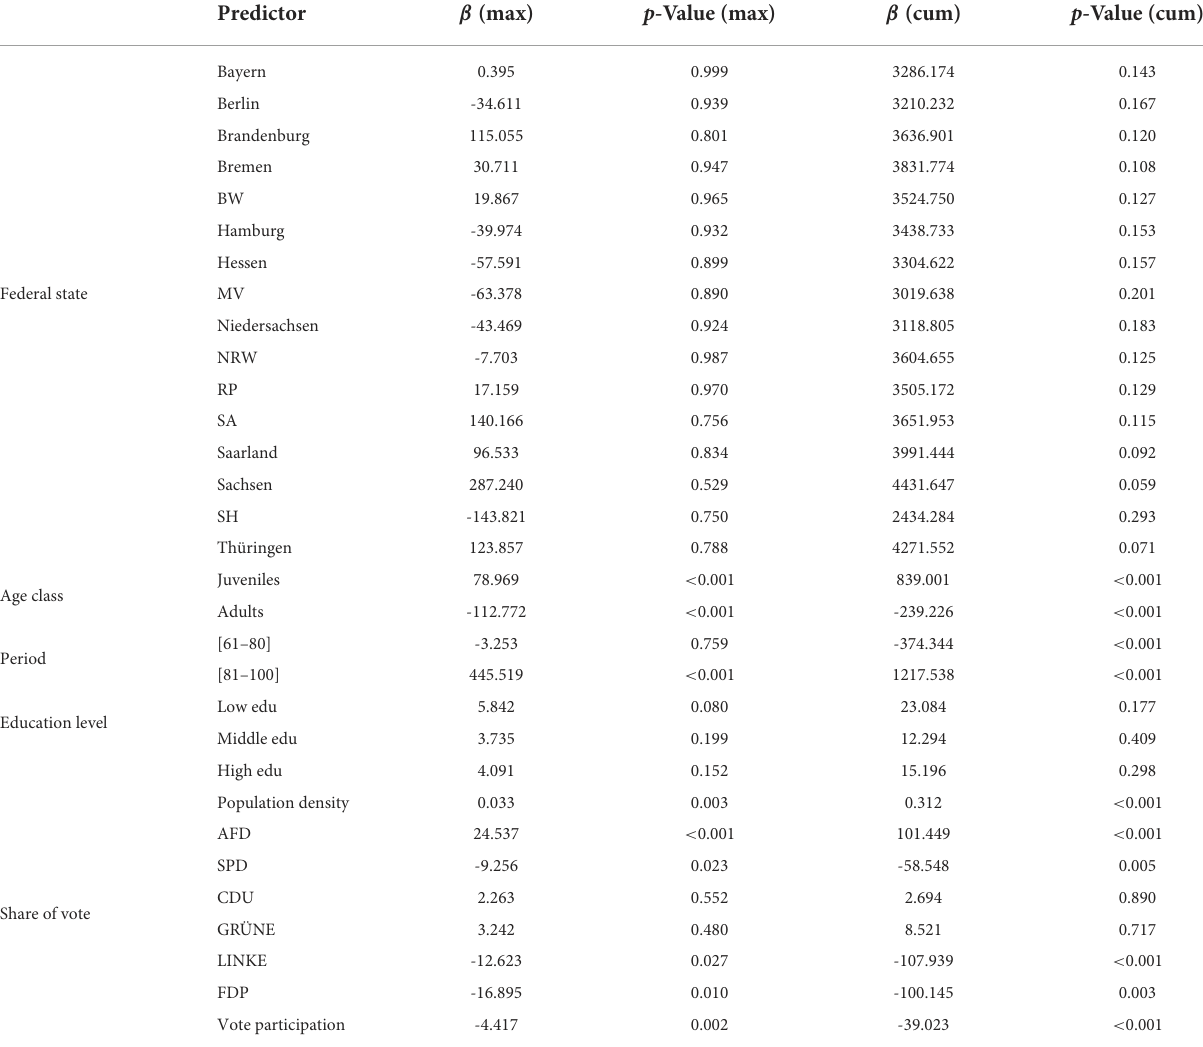
TABLE 2 Result of a linear random effects regression predicting maximum incidence (estimates indicated by “max”) or cumulative incidence (estimates indicated by “cum”), respectively, per epidemic period.